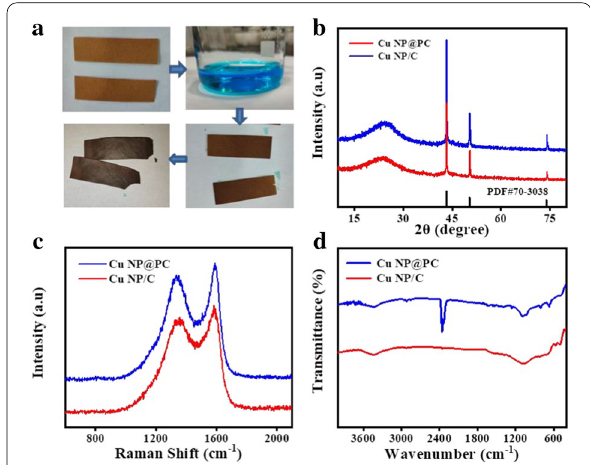
Fig. 1 a Schematic illustration of preparation of samples of Cu NP@ PC and Cu NP/C; b The X-ray diffraction (XRD) pattern of Cu